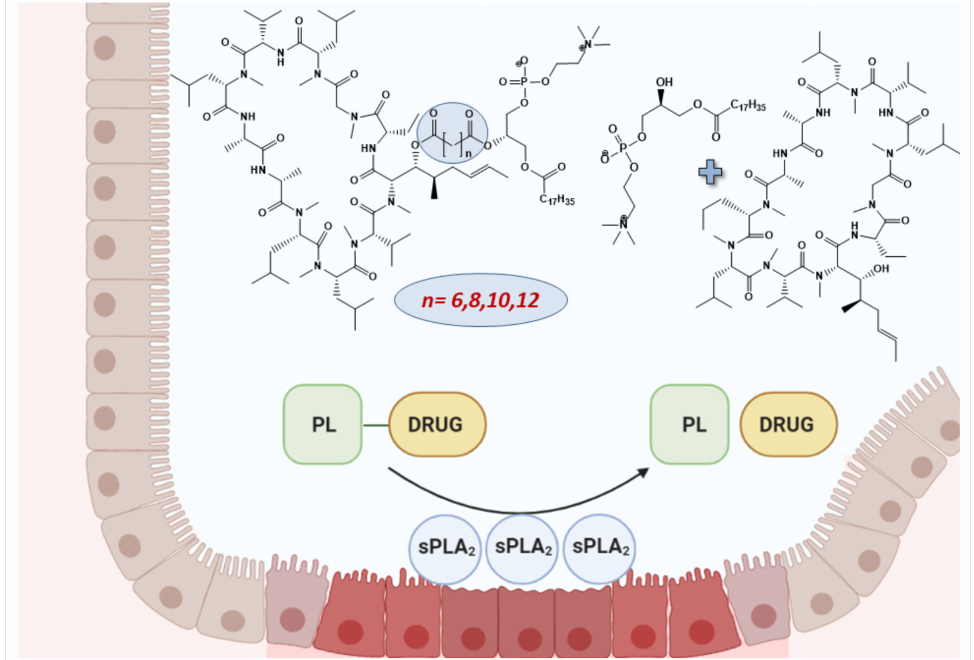
Figure 1. Illustration of PLA 2 -mediated prodrug activation in the inflamed intestinal epithelium, and chemical structures of the prodrugs with their activation products PL and cyclosporine. PLA 2 , phospholipase A 2 ; PL,